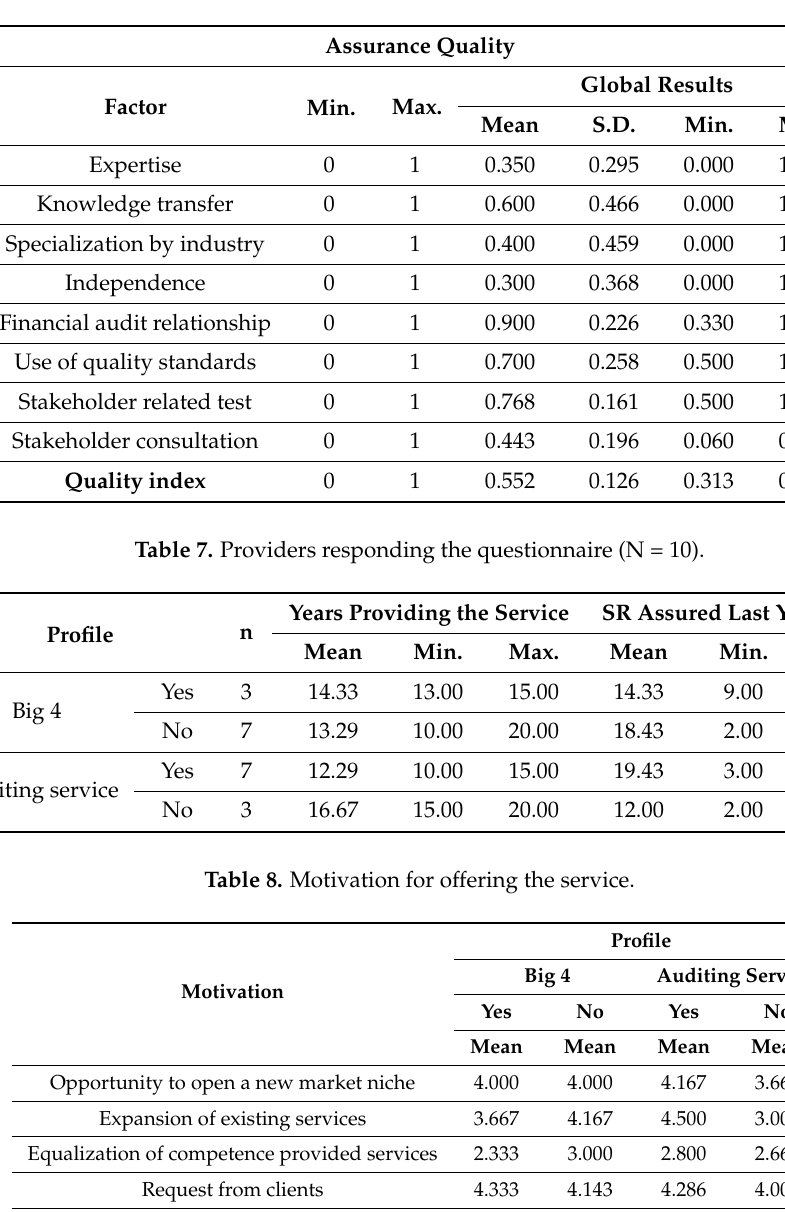
Table 6. Assurance quality: general results.